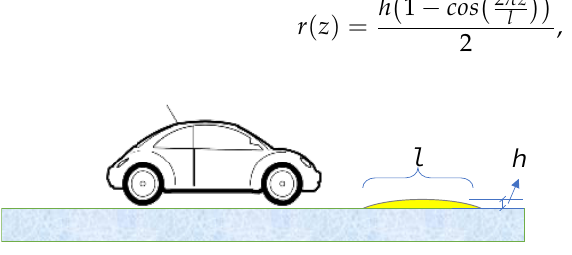
Figure 2. Diagram of a car driving over a hump.